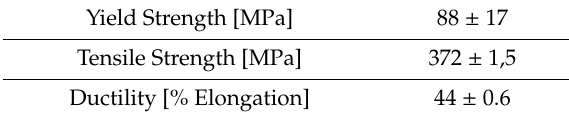
Table 2. Mechanical properties of the steel sheet used in the experiments.